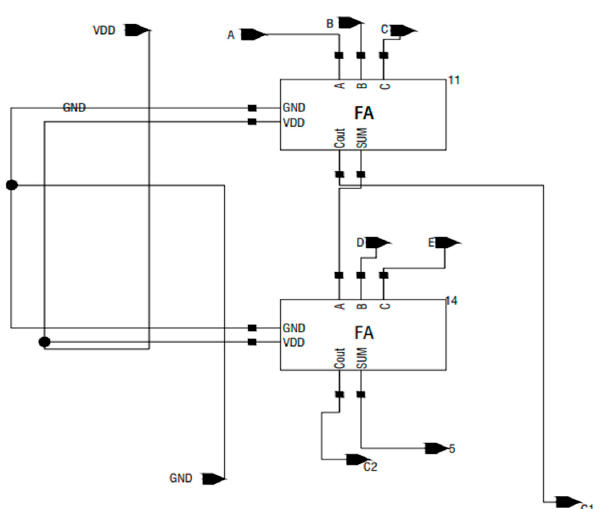
Figure 6. Schematic of 5LA.